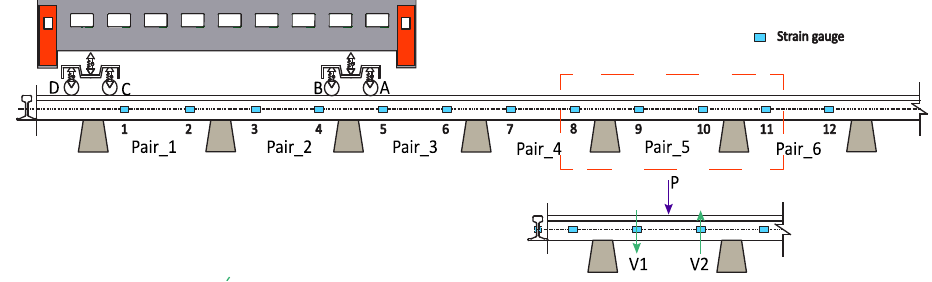
Figure 1. Schematic of the WIM system composed of six pairs of strain gauges.